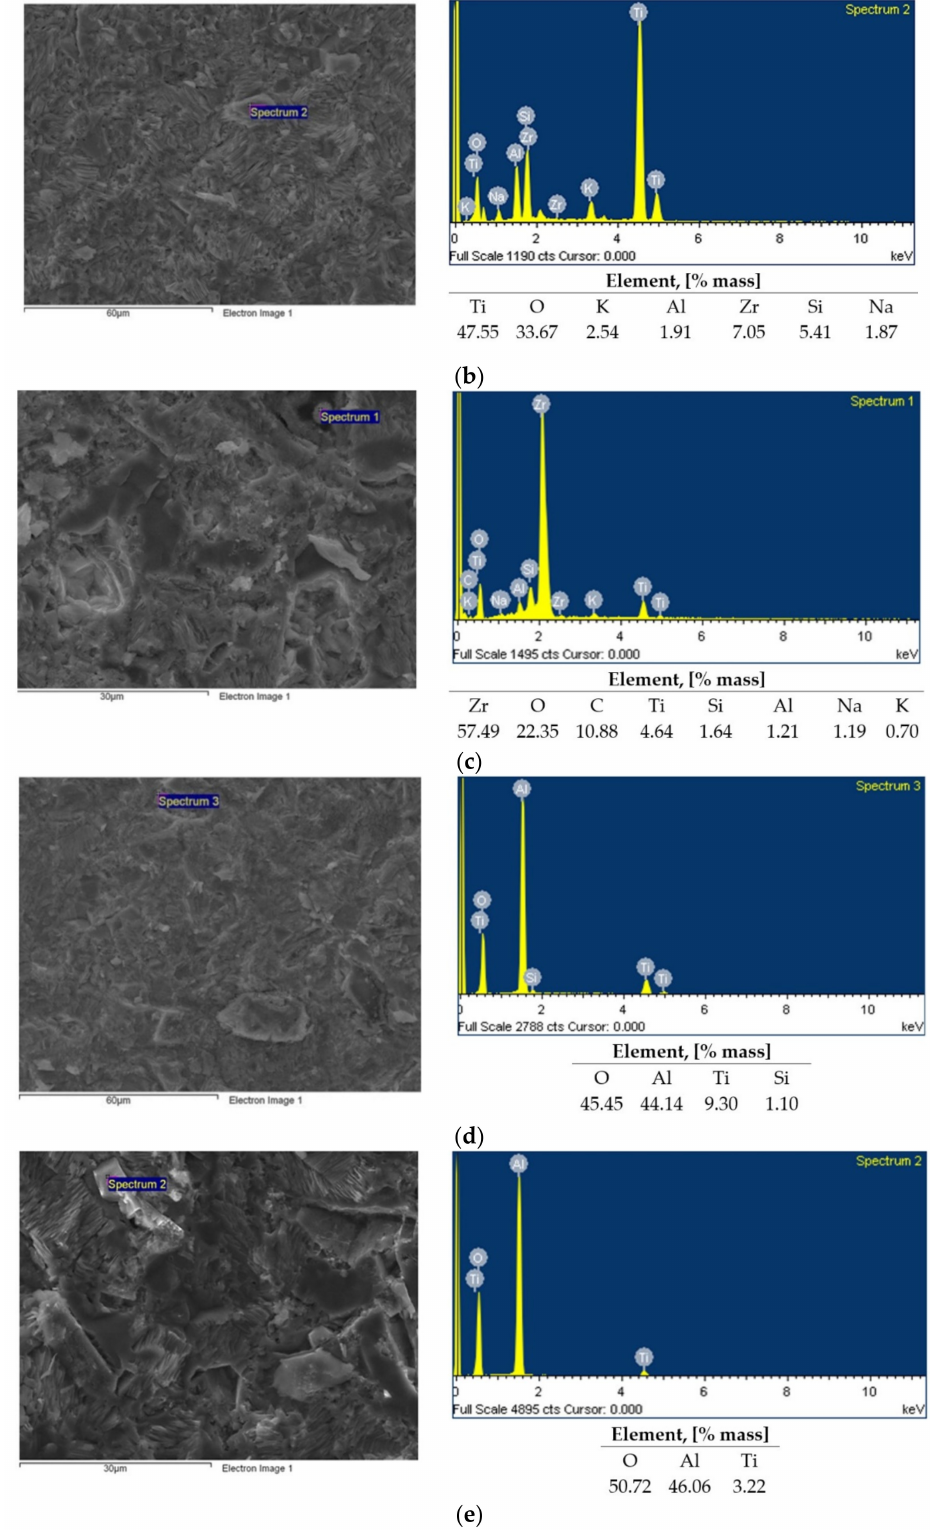
Figure 4. Microstructure and chemical composition analysis (SEM-EDS) of titanium 99.2 − Duceratin Kiss samples after mechanochemical surface treatment, ( a ) sandblasted with Al 2 O 3 , ( b ) sandblasted with Al 2 O 3 and H 3 PO 4 acid etched, ( c ) sandblasted with Al 2 O 3 and HCl acid etched, ( d ) sandblasted with Al 2 O 3 and 10% NaOH + CuSO 4 + 5H 2 O/H 3 PO 4 solution etched, ( e ) sandblasted with Al 2 O 3 and 10% NaOH + CuSO 4 + 5H 2 O/HCl solution